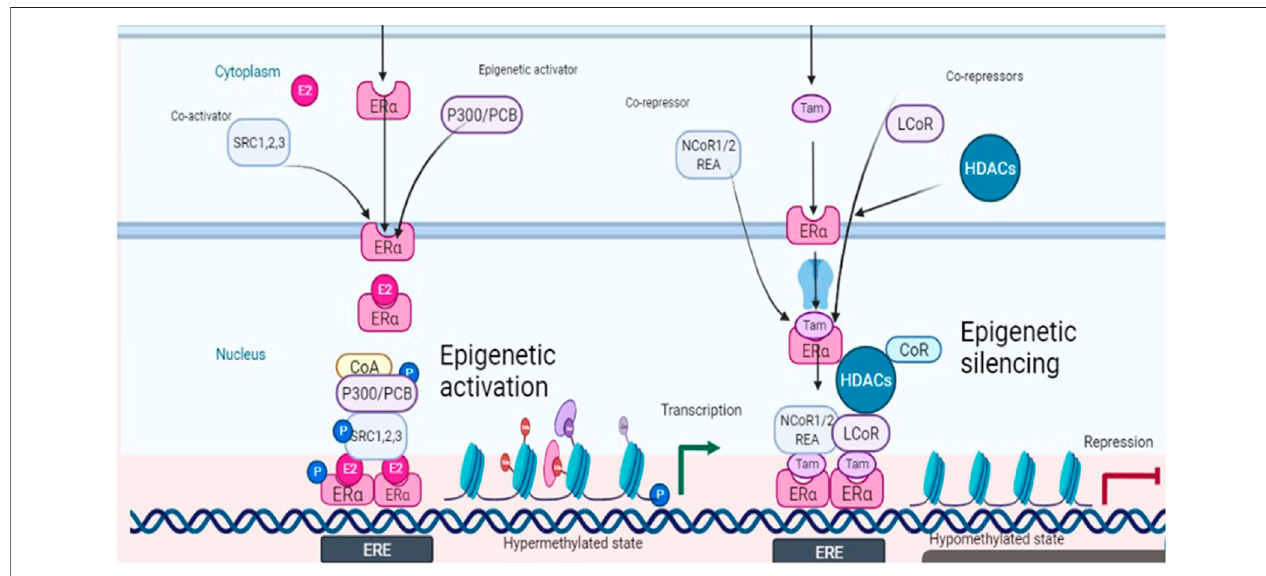
FIGURE 2 | Schematic depiction of estrogen signaling and its interactions with epigenetic events in response to estradiol (ligand) and tamoxifen (antagonist).